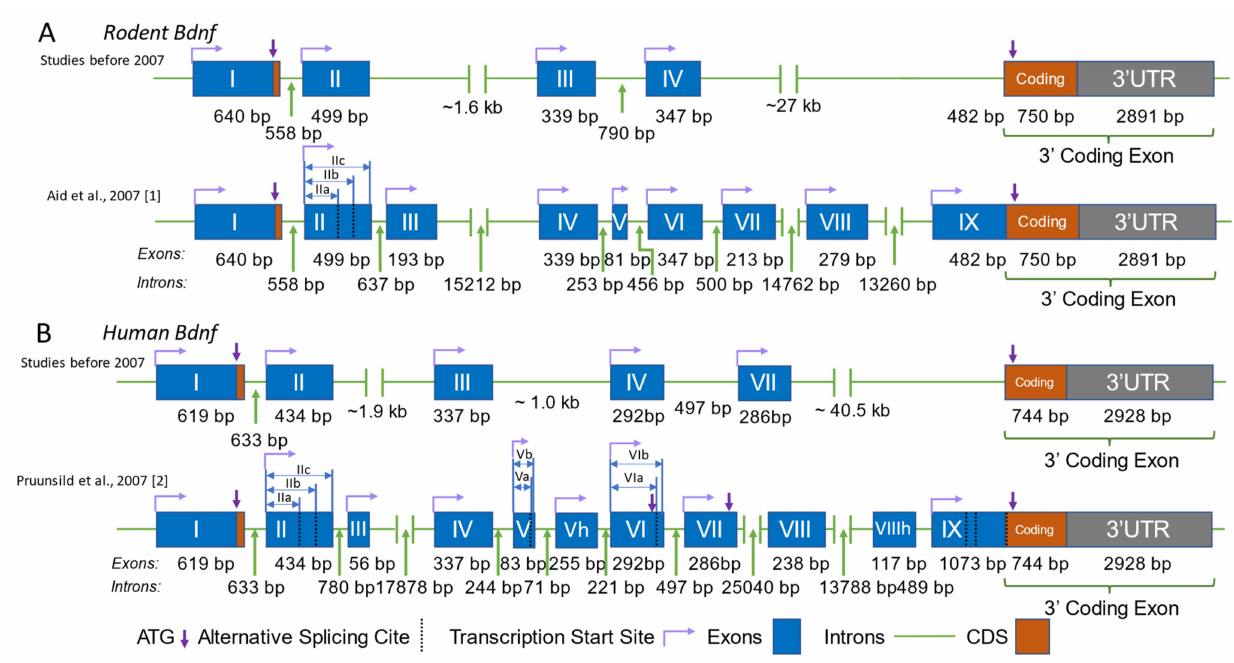
Figure 1. Genomic structure of BDNF in humans and rodents. Comparison of the genomic structure of the Bdnf gene in rodents ( A ) and humans ( B ), as proposed by studies before and after 2007. The structures presented are according to [1,2] The blue boxes represent exons, the green lines represent introns, the purple arrows indicate the translation start site (ATG), the dashed black lines indicate alternative splice sites, and the bent lines with arrows represent the transcription start site. The lengths of the exons and introns are labeled accordingly. Identical human exons and the rodent exons homologous to the human exons are named with the same number in all